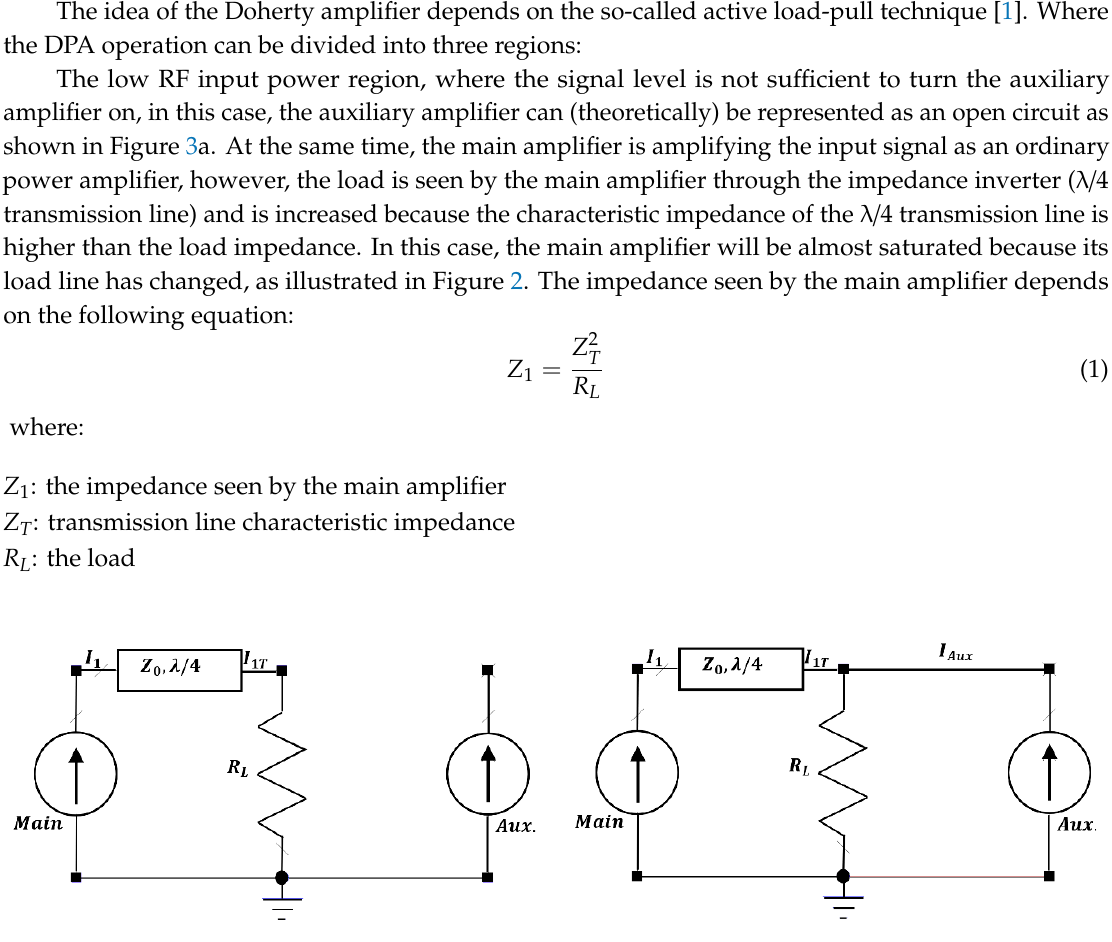
Figure 2. Main amplifier load line.